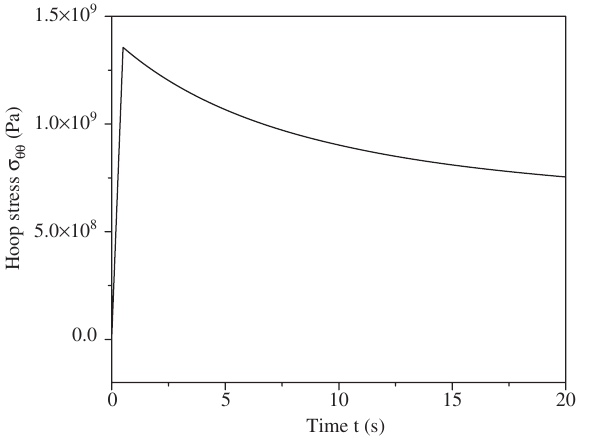
Figure 27 Response histories of hoop stress in the FGM hollow cylinder at location of (0.2625 m, π /10).